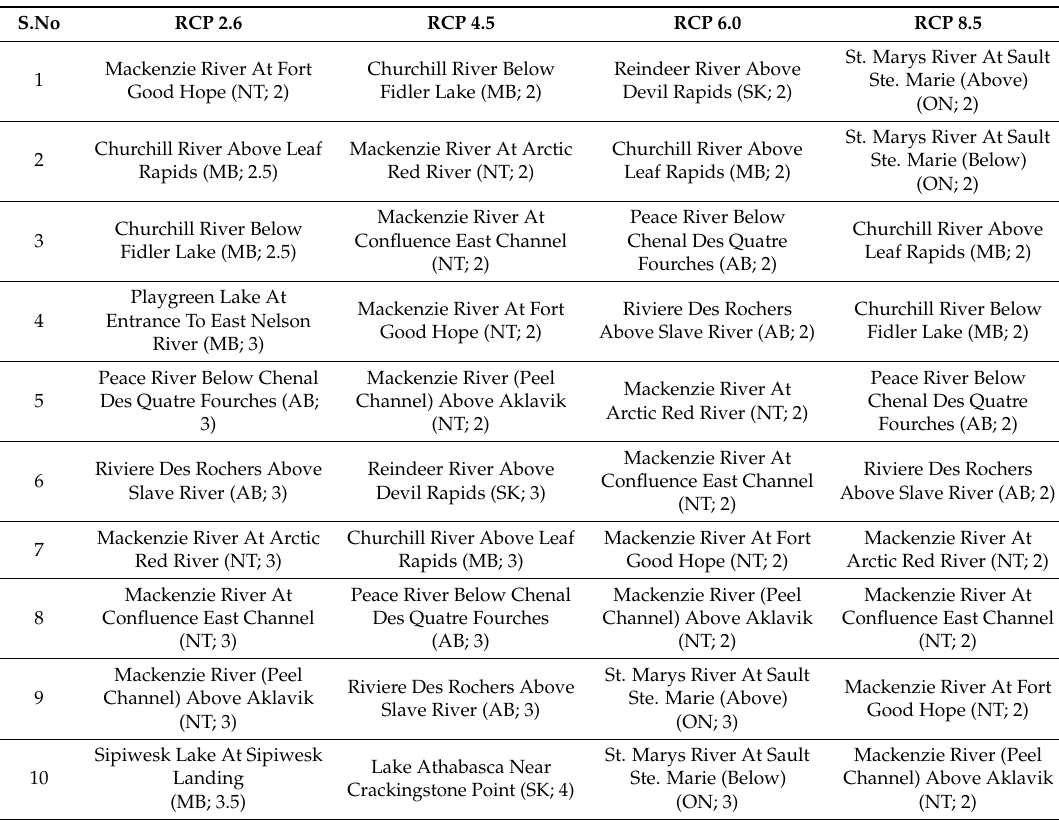
Table 8. List of 10 FRIs projected with largest increases in flooding frequencies for historical 100-year return period flooding events from all GCM median approach. Information on the province and projected future flood frequency magnitudes in years is also provided within brackets.